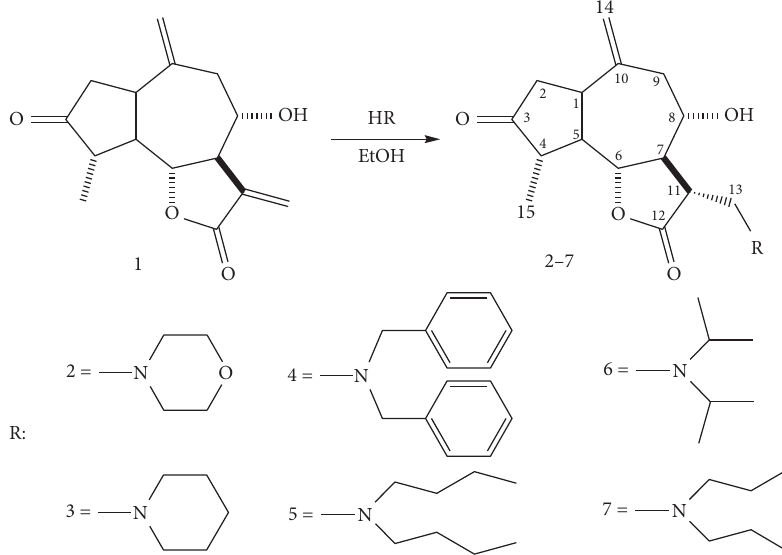
Figure 4: Scheme for the synthesis of grossgemin derivatives.